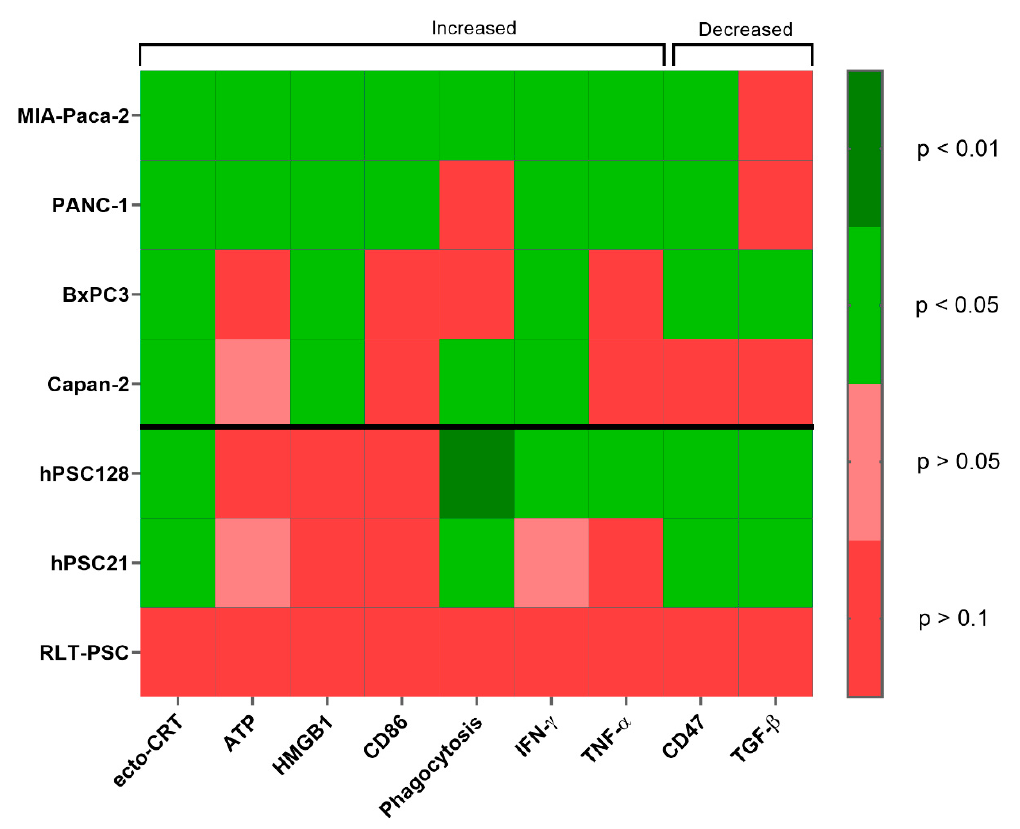
Figure 6. Overview of the p -values for all immunogenic signals tested. p -values are represented in a heatmap for the signals tested in previous experiments for both PCCs and PSCs. p -values are calculated using the Kruskall–Wallis or Mann–Whitney U test and are significant when < 0.05. Treated conditions for ecto-CRT, ATP, HMGB1, CD86, phagocytosis, IFN- γ , and TNF- α are significantly increased compared with untreated controls. Treated conditions for CD47 and TGF- β are significantly decreased compared with untreated control.